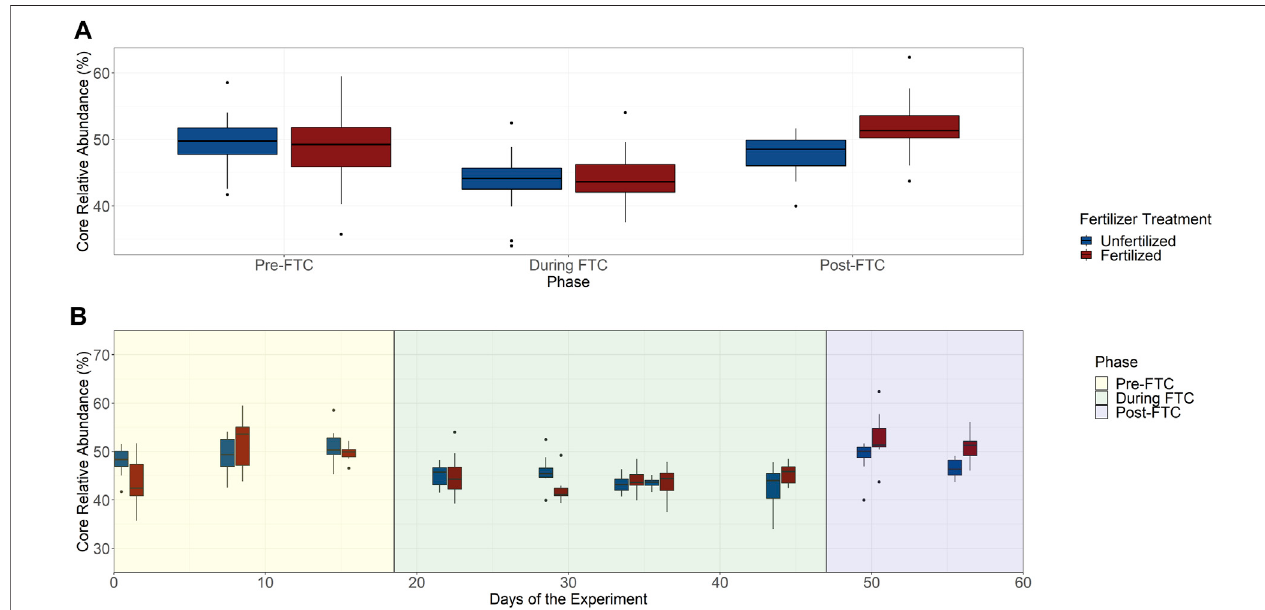
FIGURE5| Bacterialandarchaealcorecommunity.Thetotalcommunityabundanceofthe94ASVsidenti fi edasthecorecommunitywereplottedoverphasewith fertilized and unfertilized treatments plotted separately (A) . Tukey HSD tests for multiple pairwise comparisons identi fi ed signi fi cant differences associated with pre- and during FTC, and duringand post-FTC withinboth fertilizer treatments.Relativeabundancerecovers post-FTC, and thepre- and post-FTCphases werenot signi fi cantly different. Fertilizer treatments do not seem to differ within a phase except post-FTC where the fertilizer sample is signi fi cantly elevated. The difference in mean relativeabundance is~5% from pre-to during FTC and recovers post-FTC by ~4% bythe unfertilized and ~5%for the fertilized. The total communityrelativeabundance of the 94 ASVs identi fi ed for core community inclusion is plotted over time with treatments of unfertilized and fertilized columns plotted separately (B) . Adjacent time- points and fertilizer treatments do not show signi fi cant variation. The core community appears unaltered in relative community abundance under freeze-thaw or nutrient induced stress.